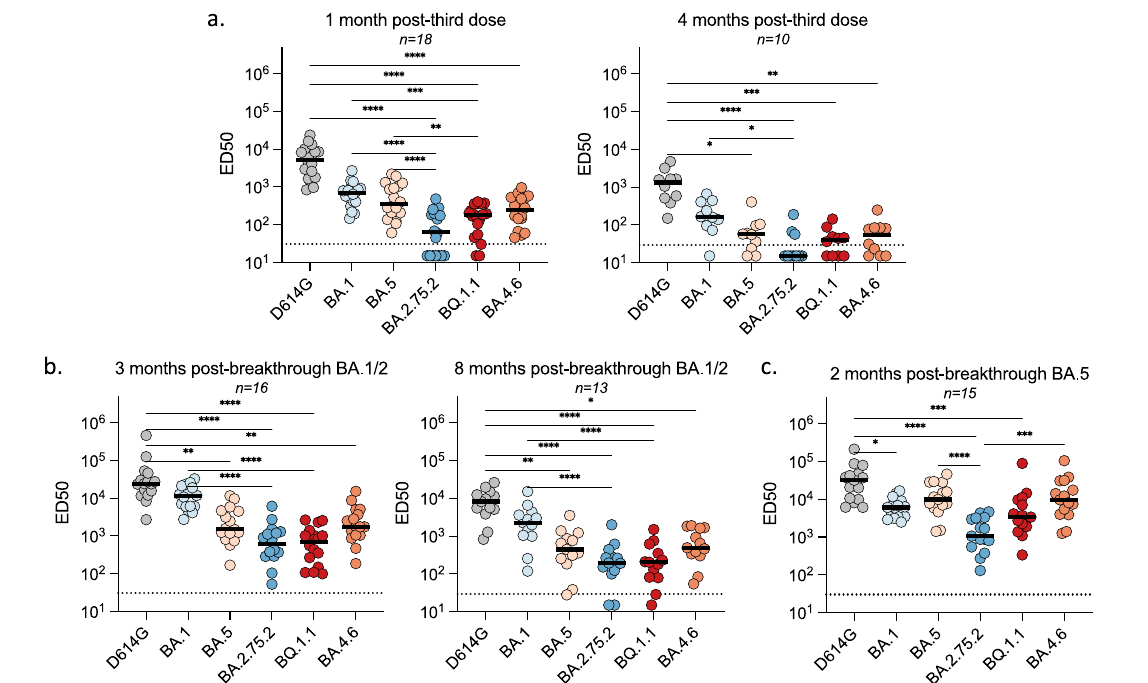
Fig.4|SensitivityofSARS-CoV-2D614GandOmicronsubvariantstoserafrom vaccinated, orinfected-then-vaccinatedindividuals. Neutralization titersof the sera against the indicated viral variants are expressed as ED50. a . Neutralizing activityofserafromindividualsvaccinatedwith3dosesofP fi zervaccine.Serawere sampled at 1 month (left panel; n =18) and 4 months (right panel; n =10) after the third dose. b Neutralizing activity of sera from P fi zer-vaccinated recipients after BA.1/BA.2 breakthrough infection. Sera were sampled about 3 months (left panel; n =16) and 8 months (right panel; n =13) after the breakthrough. c Neutralizing activityofserafromP fi zer-vaccinatedrecipientsafterBA.5breakthroughinfection. Seraweresampledabout2monthsafterthebreakthrough( n =15).Thedottedline indicates the limit of detection (ED50=30). Black lines represent the median values. Two-sided Friedman test with Dunn ’ s test for multiple comparisons was performed between each viral strain at the different time points; * p